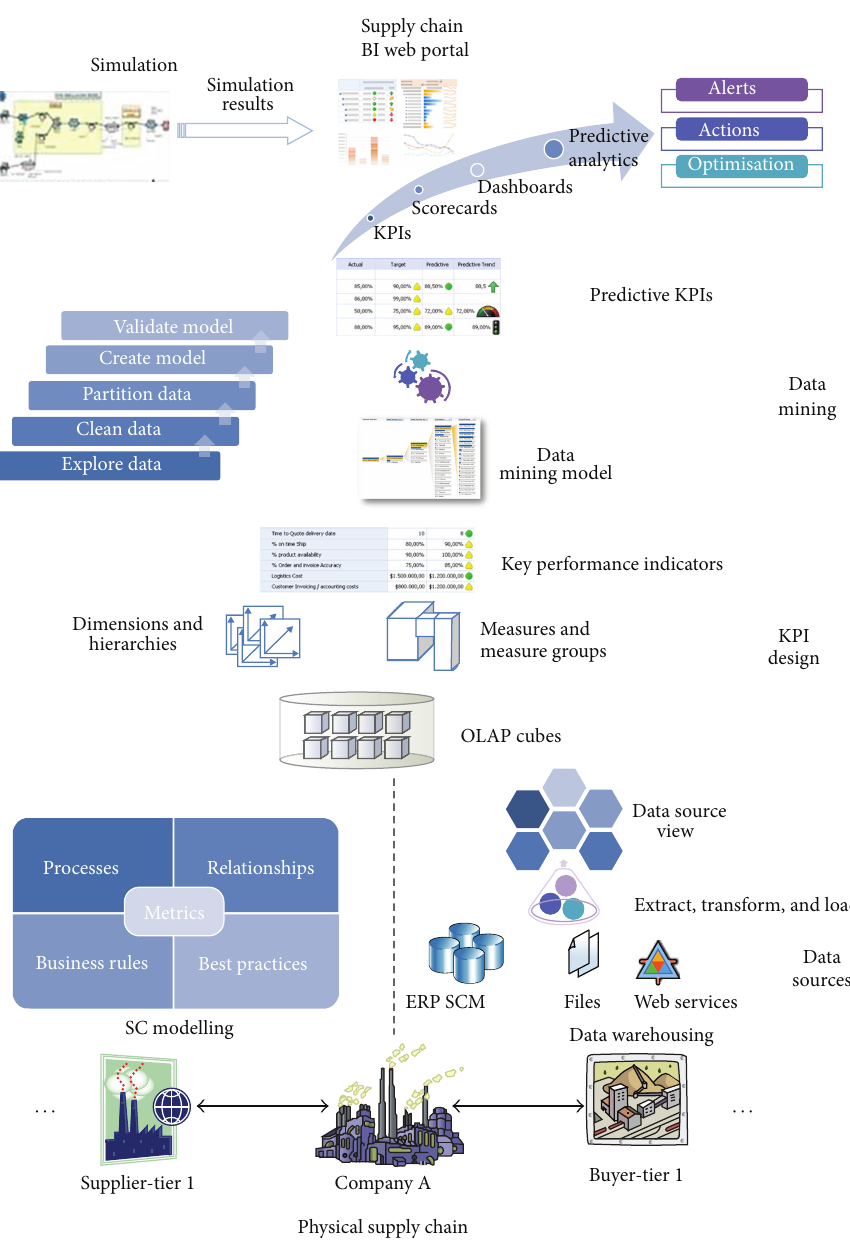
Figure 2: Predictive supply chain performance management